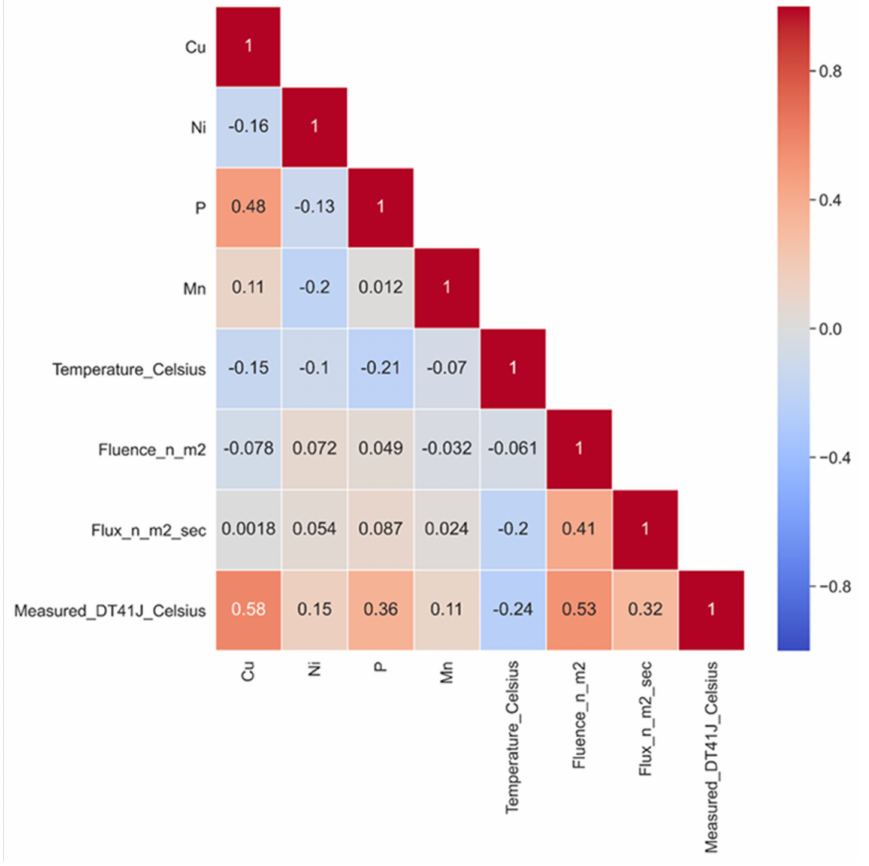
Figure 3. Pearson’s correlation matrix of the